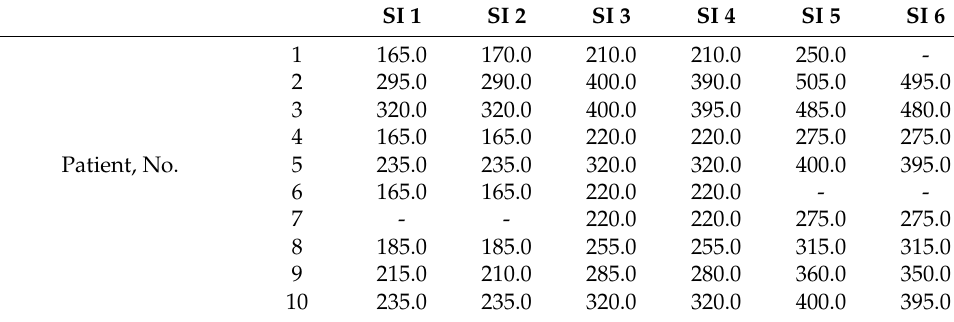
Table 2. Volumes of the study implants